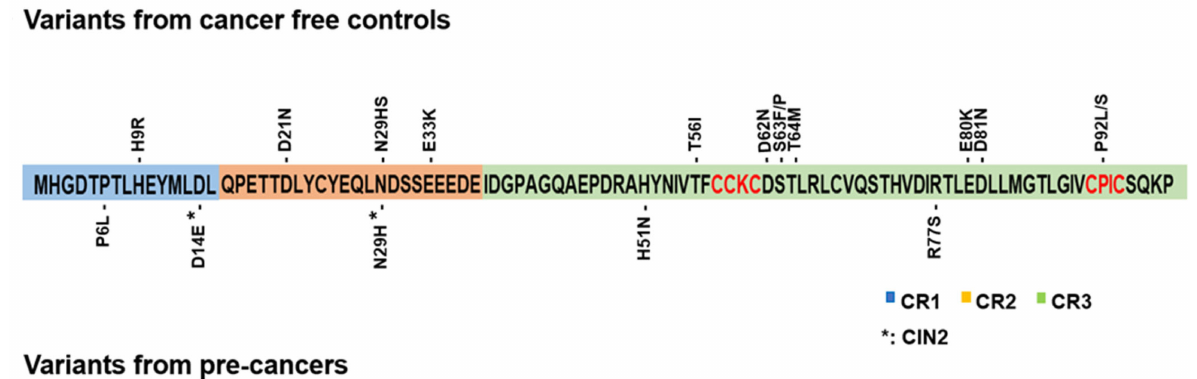
Figure 1. HPV16 E7 variants examined in this study. Schematic representation of amino acid (AA) sequences of HPV16 E7 single AA substitution mutants and their location in functional domains. Variants from cancer-free controls shown above and variants from pre-cancer samples below the functional domain. The numbers 1 to number 98 indicate the amino acid position of E7 variants. *: cervical intraepithelial neoplasia 2 (CIN2); the CXXC motif is shown in red (AA.58–61 and 91–94). Conserved regions 1, 2 and 3 are indicated (CR1, CR2,